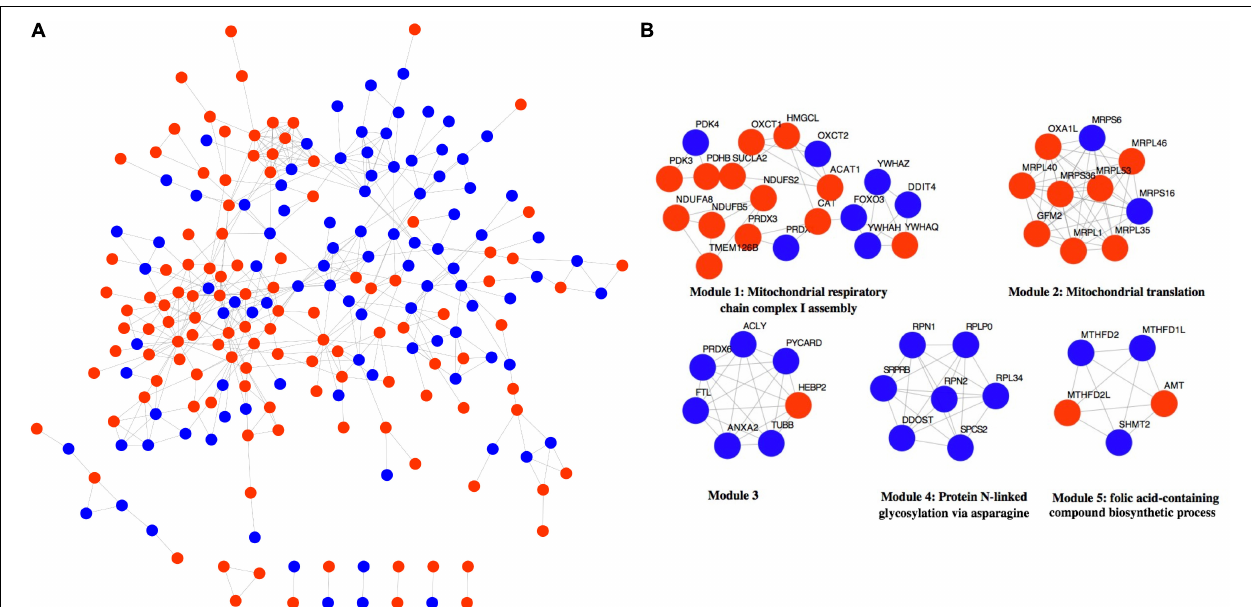
FIGURE 3 | Network analysis of 316 DE-NMGenes. (A) The PPI network consists of 440 edges and 215 nodes. Red and blue nodes represent upregulated and downregulated DE-NMGenes, respectively. (B) The network representation of modules detected from the PPI network. Red and blue nodes represent upregulated and downregulated NMGenes, respectively.